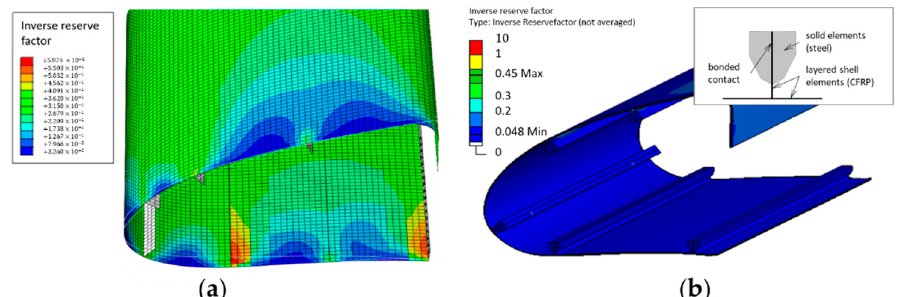
Figure 10. Inverse reserve factors due to thermal residual stresses in the undeformed skin for cooling to − 45 ◦ C; ( a ) ABAQUS-model (linear shell elements) of the CRFP-only stringers largely shows inverse reserve factor (IRF)-values (even without morphing) of ca. 0.35 (green) and above; ( b ) ANSYS-model (linear shell elements—here displayed with their specified thickness) shows IRF-values mostly around 0.1 and below (also without morphing); upper right corner: Design principle of the stringer-reinforcement assumed for the ANSYS-model (this has since been superseded by the design shown in Figure 11).